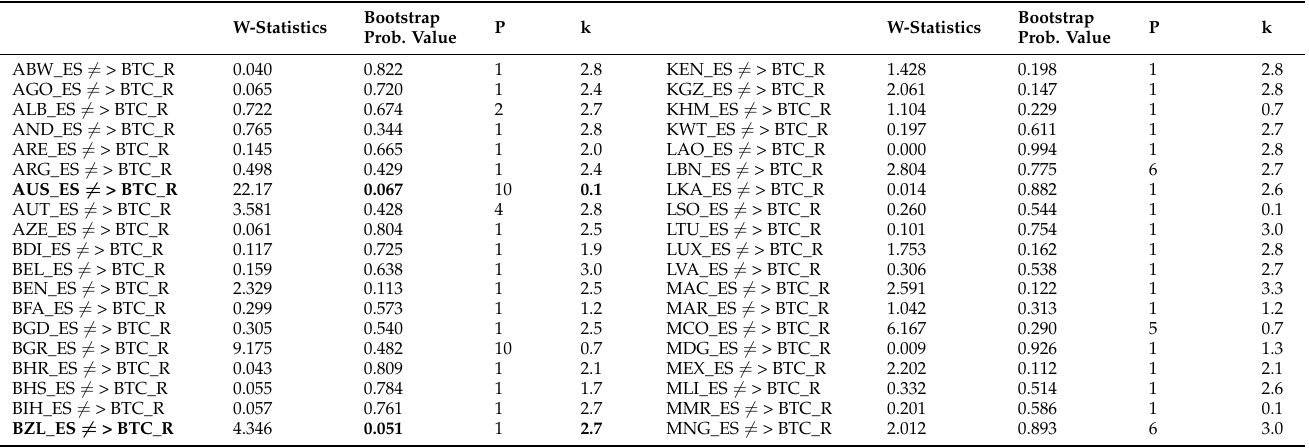
Table 4. Fractional Frequency Flexible Fourier form Toda–Yamamoto causality tests between eco- nomic supports and Bitcoin return